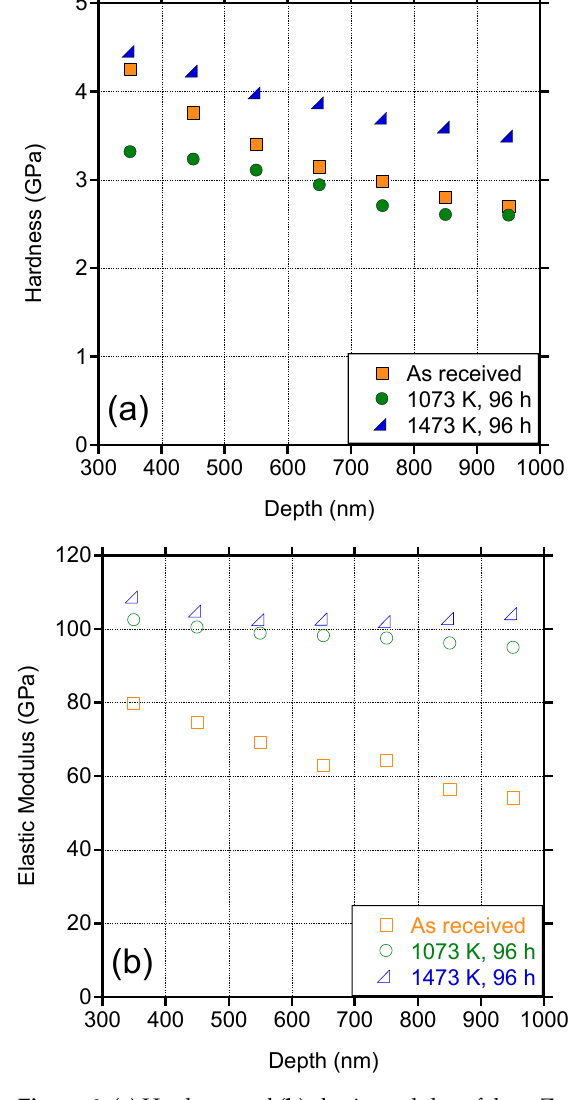
Figure 6. ( a ) Hardness and ( b ) elastic modulus of three Zry-4 samples as a function of depth pene- tration. Table 3. Summary of elastic modulus and hardness values as obtained from nanoindentation tests on as received Zry-4 and carburized Zry-4.